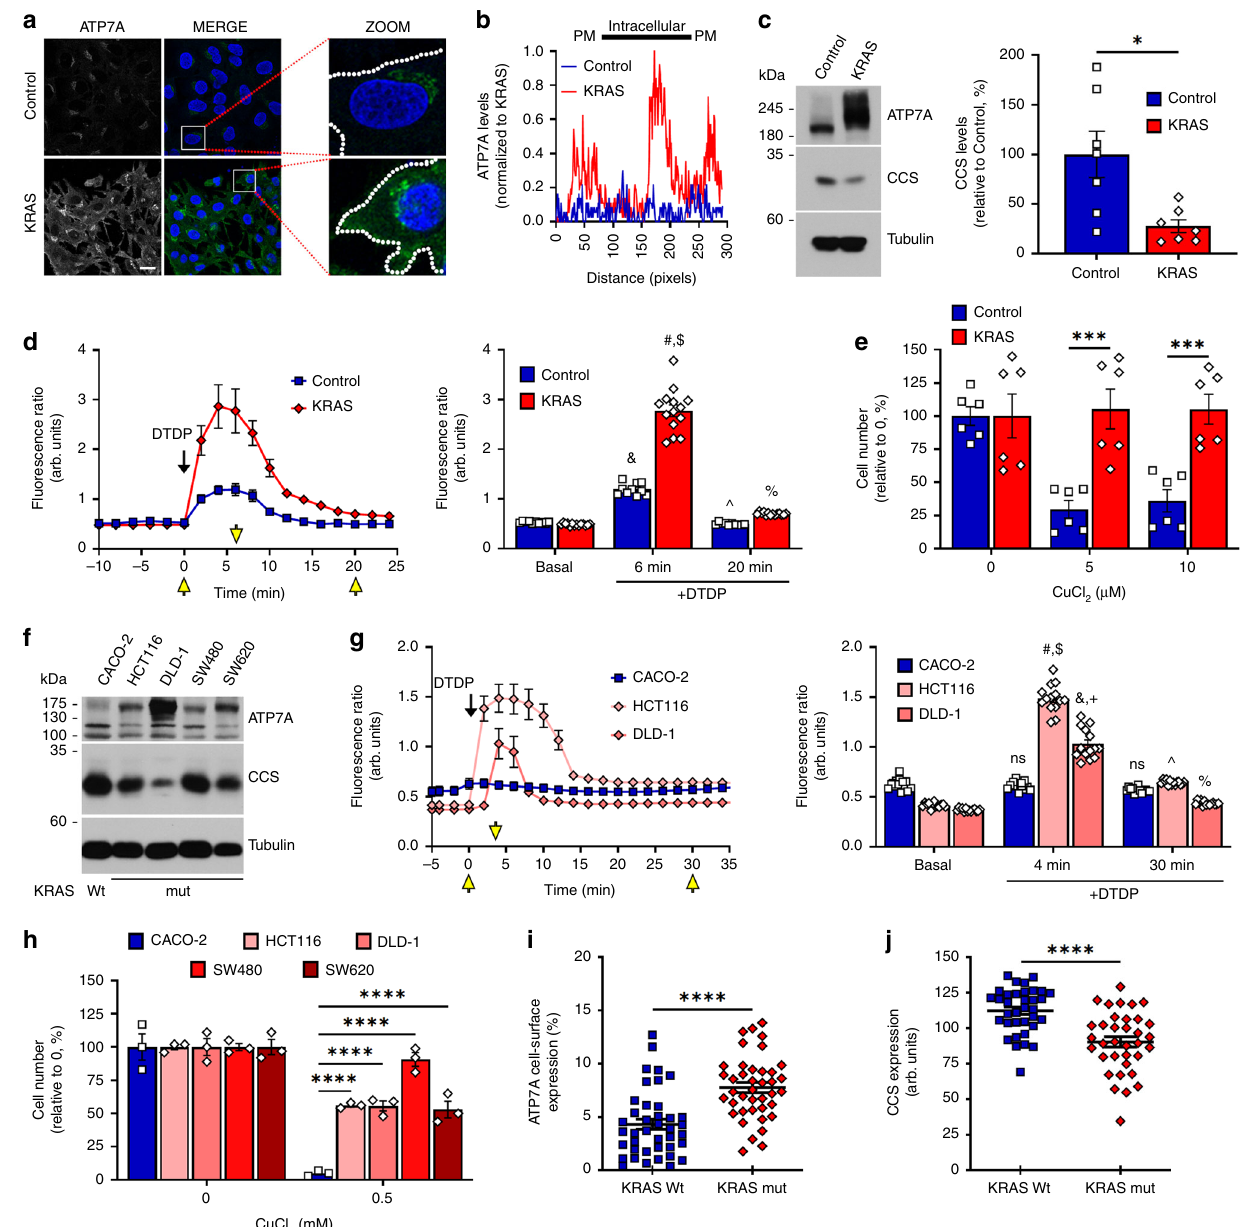
Fig. 3 ATP7A protects KRAS-mutant cells from cuproptosis. a Micrographs showing ATP7A expression (green) and DAPI (blue) in Control and KRAS cells. Scale = 20 µ m, n = 3 independent experiments. b Cellular distribution pro fi le of ATP7A as seen in a for Control (blue line) versus KRAS (red line) cells. Data were normalized to KRAS. PM plasma membrane. c IB for CCS and ATP7A expression in Control and KRAS cells, with CCS quanti fi cations (right). All panels represent n = 7 independent experiments. * P = 0.0110. d Time-course of average crisp-17 fl uorescence ratios ( n = 10 cells) upon addition of DTDP at T = 0 min. Yellow arrows indicate timepoints for which quanti fi cations are shown (right). P -values are represented as Control-basal versus DTDP (6 min) (&), Control-DTDP (6 min) versus KRAS-DTDP (6 min) (#), KRAS-basal versus DTDP (6 min) ($), Control-DTDP (6 min) versus DTDP (20 min) (^), KRAS-DTDP (6 min) versus DTDP (20 min) (%). e Graph depicting relative cell viability after CuCl2 treatment. Data represent n = 6 independent experiments.*** P = 0.0002 (Control versus KRAS-5); *** P = 0.0006 (Control versus KRAS-10). f IB depicting ATP7A and CCS levels in the indicated CRC cells. Data represent n = 3 independent experiments. g As in d but for CRC ( n = 14 cells). P -values are represented as CACO-2-basal versus DTDP (4 min) (ns), CACO-2-DTDP (4 min) versus HCT116-DTDP (4 min) (#), HCT116-basal versus DTDP (4 min) ($), CACO-2-DTDP (4 min) versus DLD-1-DTDP (4 min) (&), DLD-1-basal versus DTDP (4 min) ( + ), CACO-2-DTDP (4 min) versus DTDP (30 min) (ns), HCT116-DTDP (4 min) versus DTDP (30 min) (^), DLD-1-DTDP (4 min) versus DTDP (30 min) (%). h As in e but for CRC cells. Data represent n = 3 independent experiments. i , j Graphs represent expression of cell-surface ATP7A ( i , n = 40 random images from fi ve patient-derived CRC tumors) and total CCS ( j , n = 35) analyzed by immunohistochemistry. For c – e , g – j center values and error bars represent mean ± SEM and for left panels ( d , g ), mean ± SD. For d , g , h ns not- signi fi cant or **** P < 0.0001 (&, #, + , $, ^, %). Signi fi cance was determined using unpaired two-tailed Student ’ s t -tests ( c , d , g , i , j ) or two-way ANOVA with post-hoc Bonferroni ’ s multiple-comparison analysis ( e , h